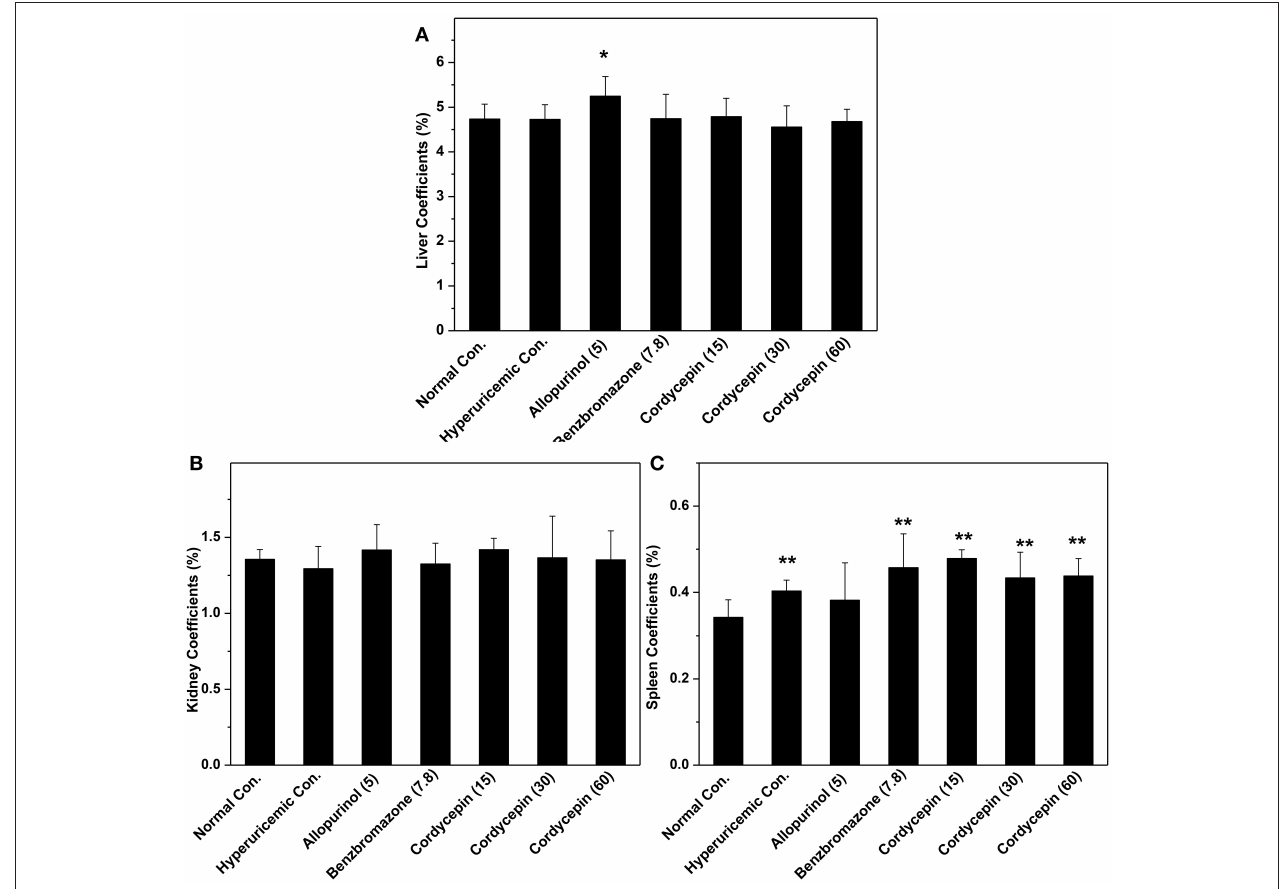
FIGURE 4 | Organ coefficients: (A) liver coefficient; (B) kidney coefficient; (C) spleen coefficient. * P < 0.05, ** P < 0.01 vs. hyperuricemic control.